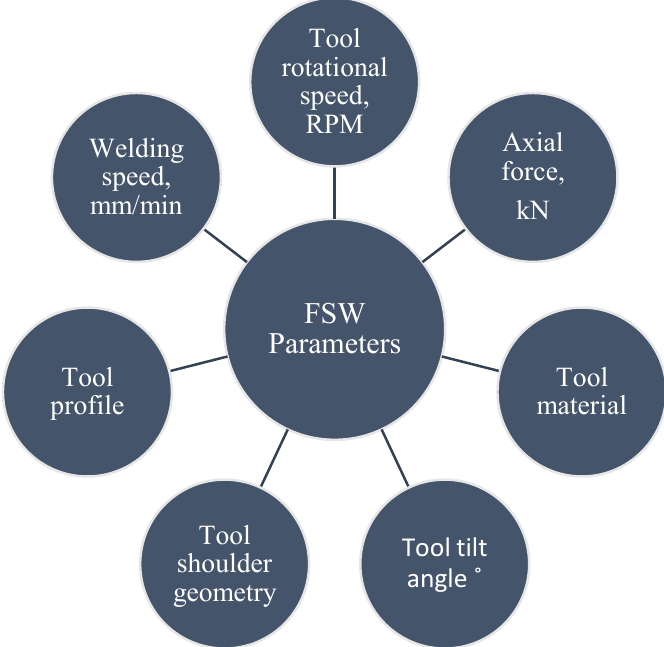
Fig. 4 Cloud Database for CNC based Automated Friction Stir Welding Cell [7]-[14]